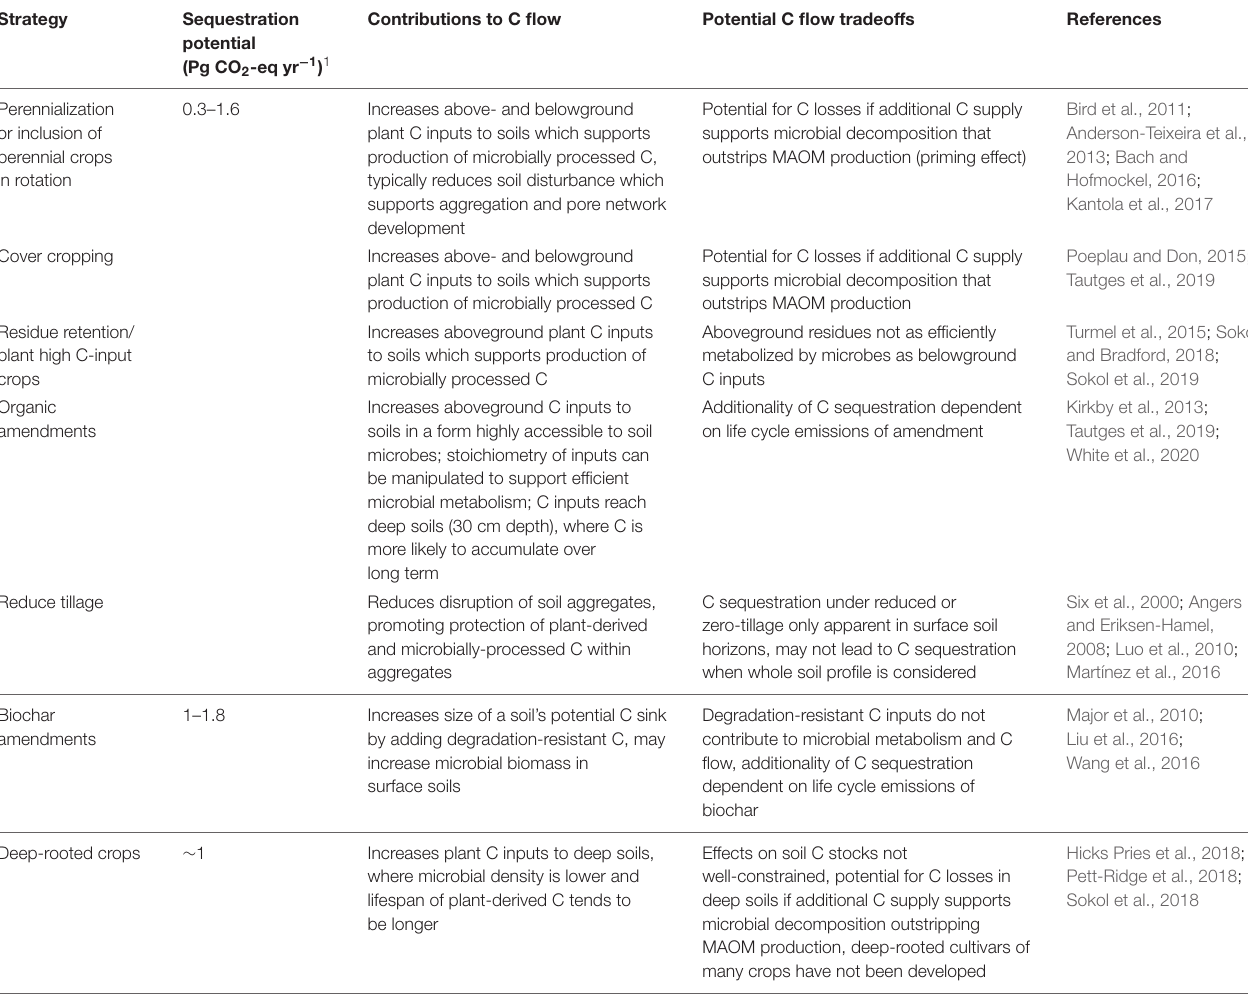
TABLE 1 | Sequestration potential, contributions to C flow, and trade-offs/constraints of selected cropland management practices (compiled from Paustian et al., 2016 and Chenu et al., 2019) that are most related to the soil C flow conceptual model developed in this